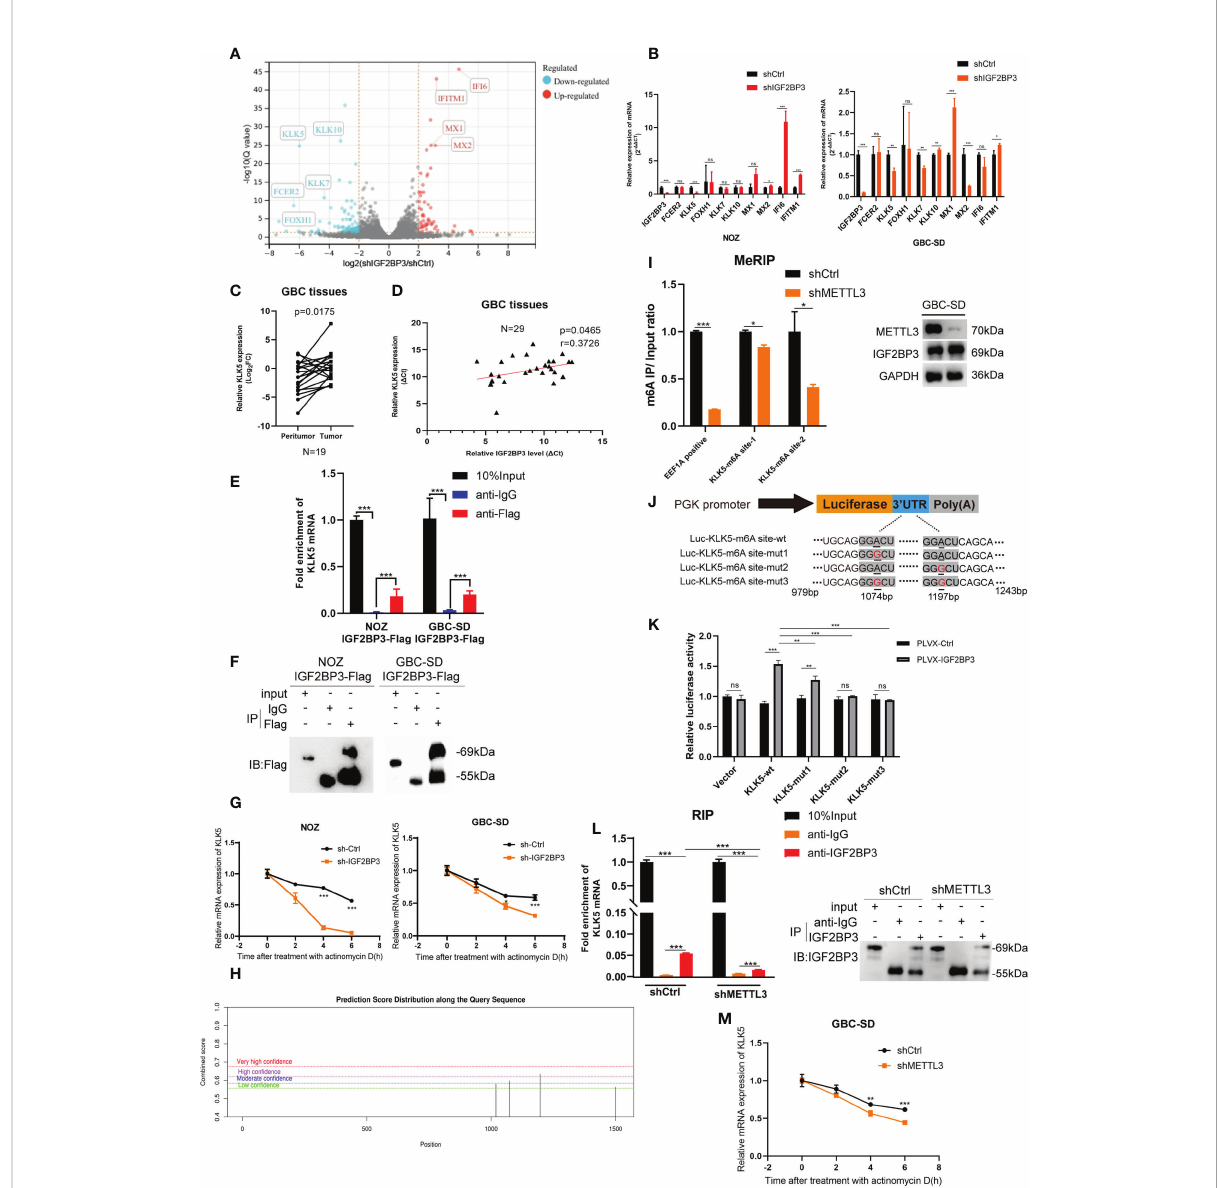
FIGURE 4 KLK5 was regulated by IGF2BP3 via direct binding. (A) RNA-seq was performed between shIGF2BP3 and shCtrl cells and the differentially expressed genes are shown in a volcano plot. (B) qPCR was performed to verify the downstream target in treated cells of NOZ and GBC based on the results of RNA-seq. (C) The KLK5 mRNA levels were measured in 19 pairs of GBC tumor and peritumoral samples. (D) The relationship between IGF2BP3 and KLK5 mRNA was analyzed using Pearson correlation tests in 29 GBC tumor tissues. (E, F) RIP assay was performed in GBC cells ectopically expressing IGF2BP3-Flag to detect the binding of IGF2BP3 and KLK5 mRNA. Results shown are from qPCR (E) and western blotting (F) . (G) RNA stability tests were performed in GBC cells treated with actinomycin D (10 m g/ml), and U6 was used as the endogenous control. (H) The putative m6A sites of KLK5 mRNA predicted by SRAMP. (I) MeRIP-qPCR was performed in GBC-SD cells with or without METTL3 depletion, and the METTL3 silencing was validated by western blotting (right). The enrichment levels of m6A modi fi ed RNA was shown in the left part. (J) Luciferase reporter plasmids containing m6A sites of KLK5 mRNA and the point-mutant plasmids were constructed. (K) Results of dual-luciferase reporter assay to verify the recognition of IGF2BP3 and m6A sites of KLK5 mRNA. (L) RIP assay was performed in GBC-SD cells with or without METTL3 depletion to measure the binding between IGF2BP3 and KLK5 mRNA. Results shown are from qPCR (left) and western blotting (right). (M) RNA stability tests were performed in GBC-SD transfected with shMETTL3 or shCtrl after actinomycin D (10 m g/ ml) treatment, and U6 was used as the endogenous control. Paired t test was used in (C) Unpaired t test was used in (B, E, G, I, K, L, M) . Data is shown as mean ± SD; * P < 0.05. ** P < 0.01. *** P < 0.001. ns means no signi fi cance in statistical